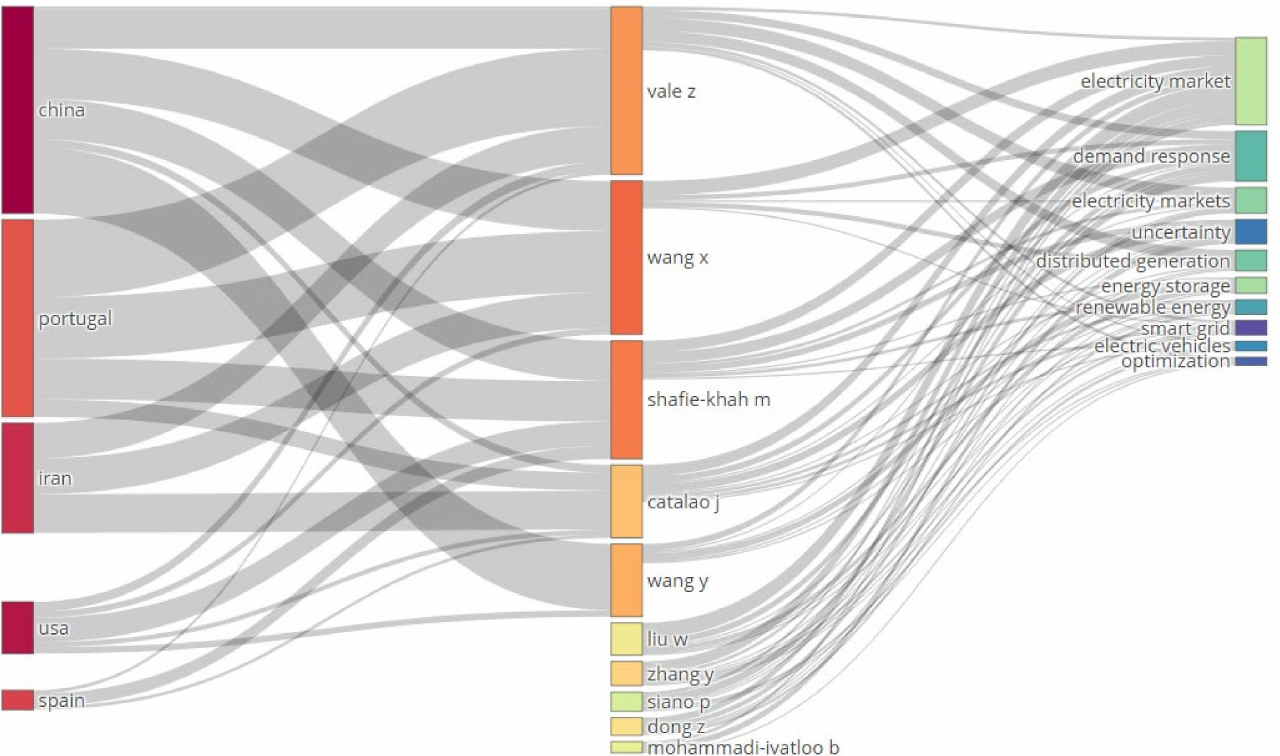
Figure 4. Three-field plot (countries/authors/keywords). Source: own study, elaborated by